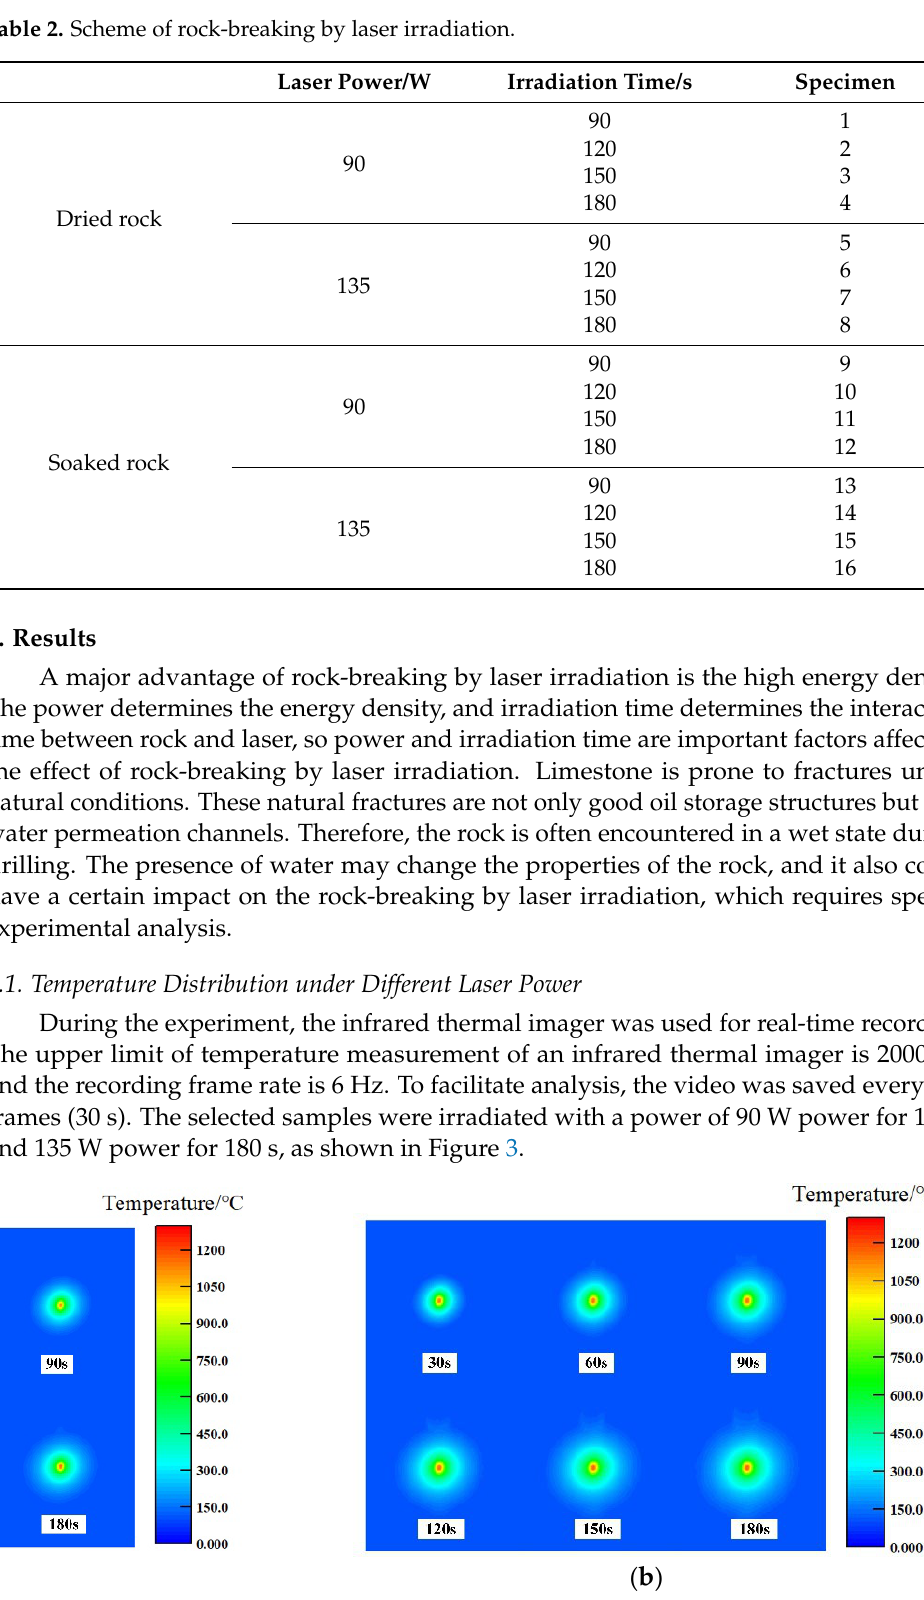
Figure 3. Temperature distribution after laser irradiation with different laser power ( a ) 90 W; and ( b ) 135